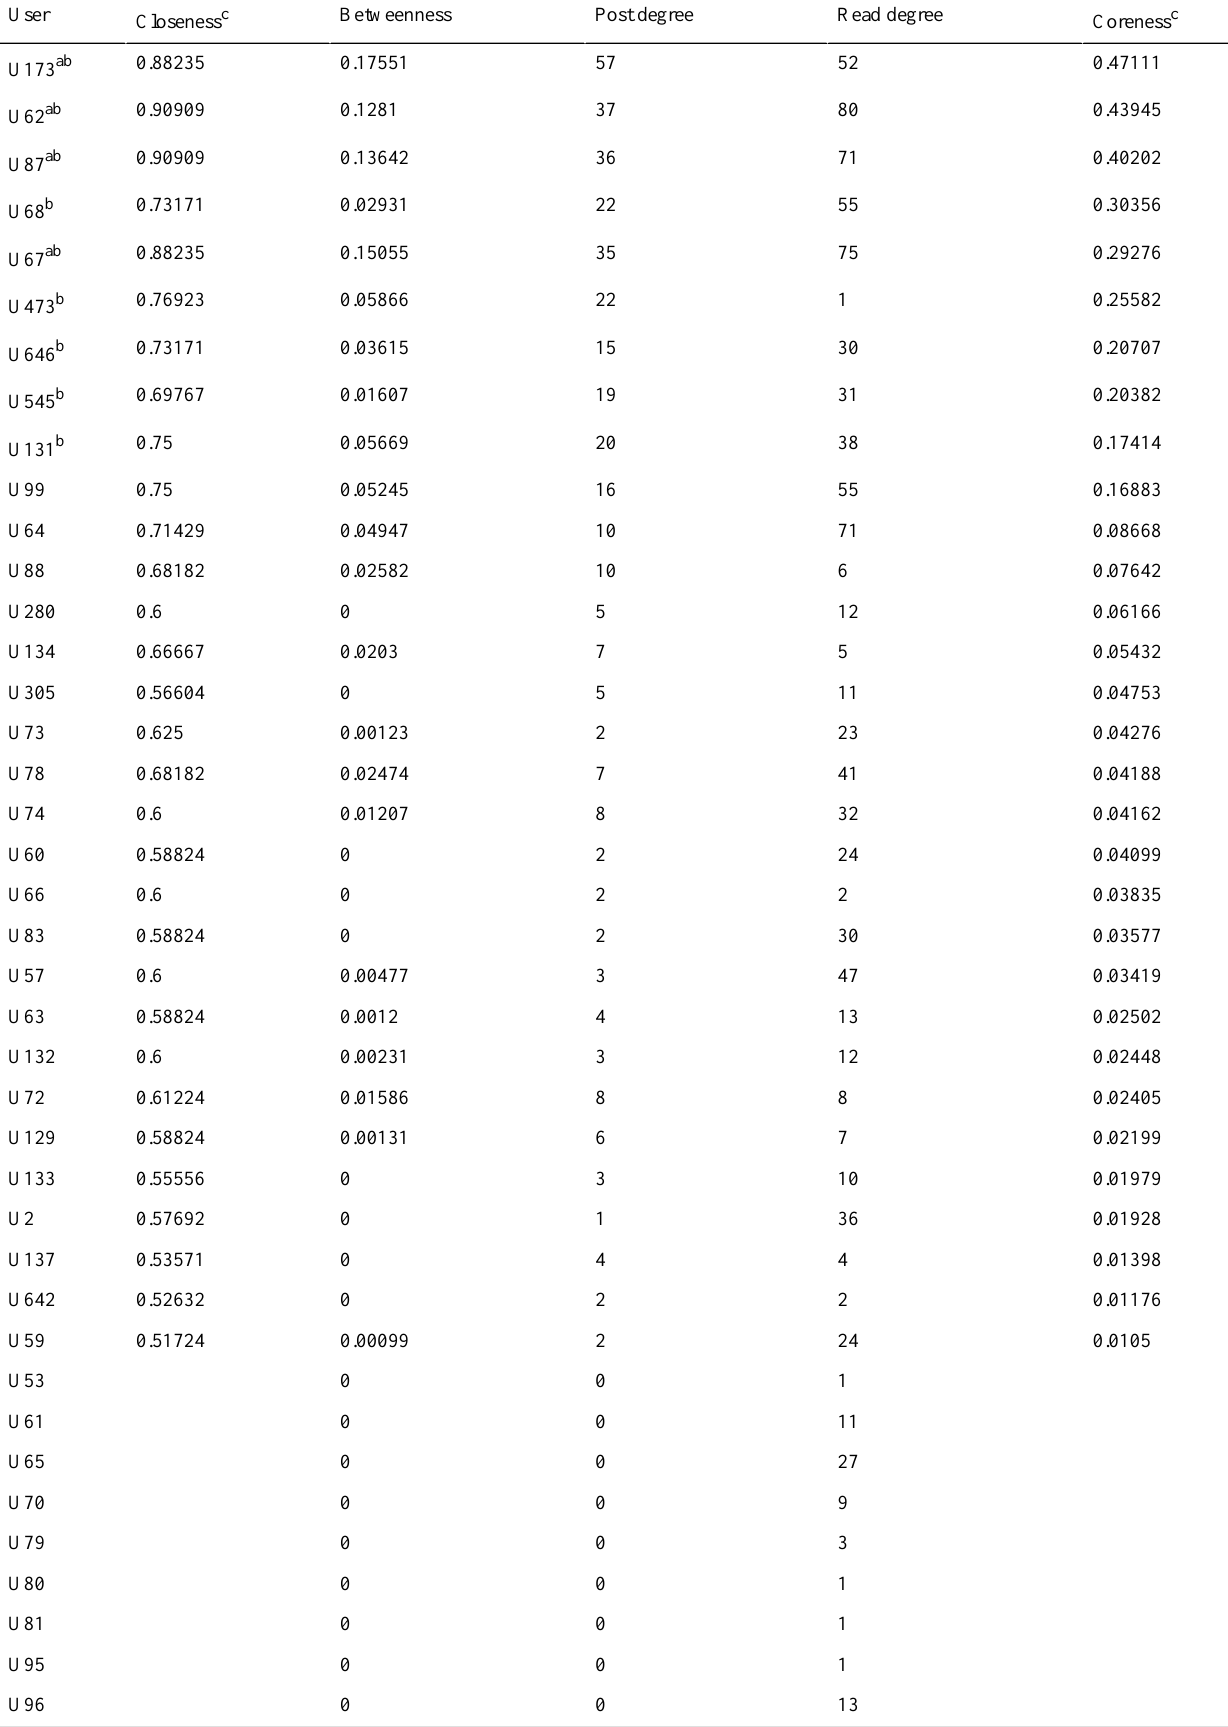
Table 2. A sample of centrality for social network members, ordered by